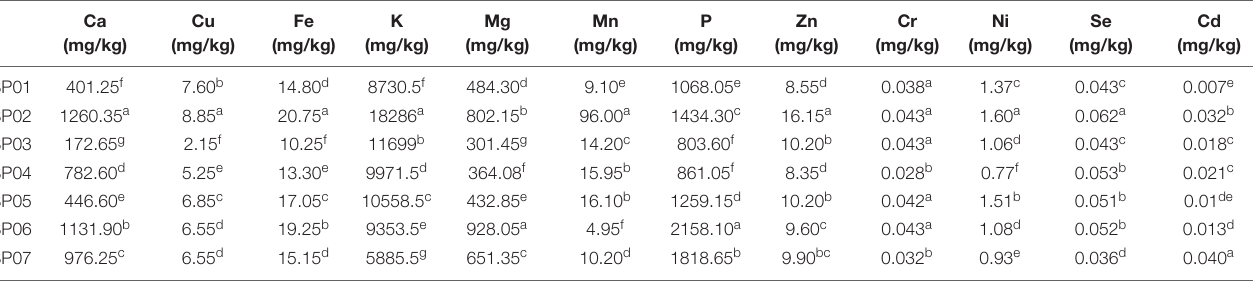
TABLE 4 | The mineral content of sweet potato powder with different varieties.